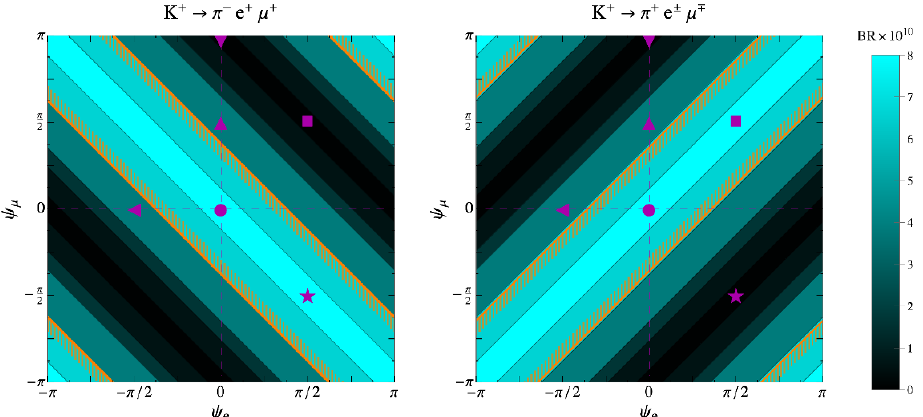
Figure 2 . Branching ratios of the LNV K + ! (cid:25) (cid:0) e + (cid:22) + decay (left) and of the LNC K + ! (cid:25) + e (cid:6) (cid:22) (cid:7) decay (right), represented via coloured isosurfaces on the e (cid:0) (cid:22) plane. In each panel, the orange lines denote the corresponding current experimental bounds (cf. eqs. (4.1), (4.3)). The di(cid:11)erent superimposed symbols correspond to the illustrative points used in the